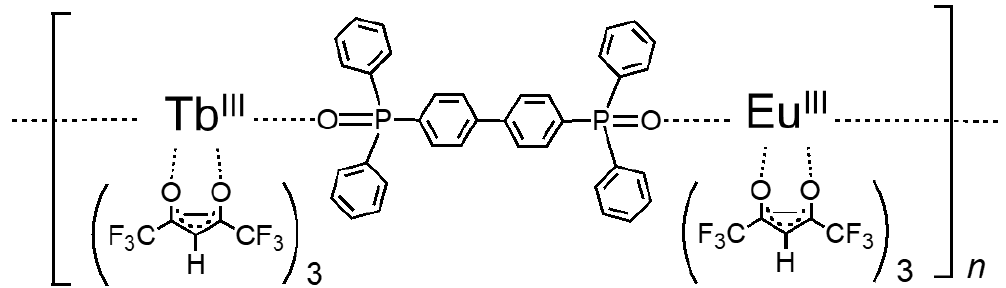
Figure 1. Chemical structure of the chameleon luminophore